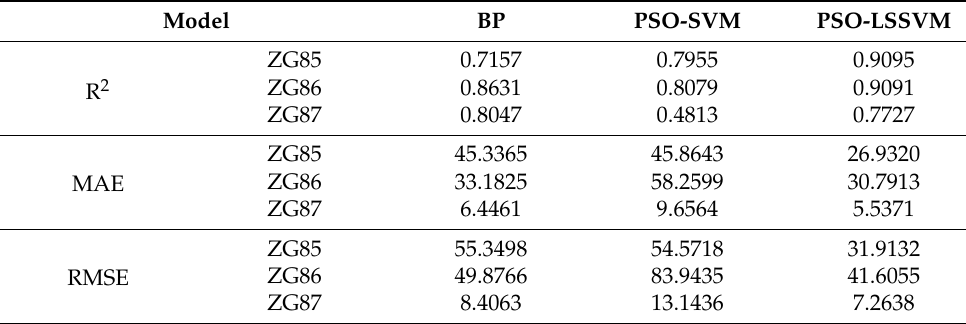
Table 3. The error of the PTD of each model.